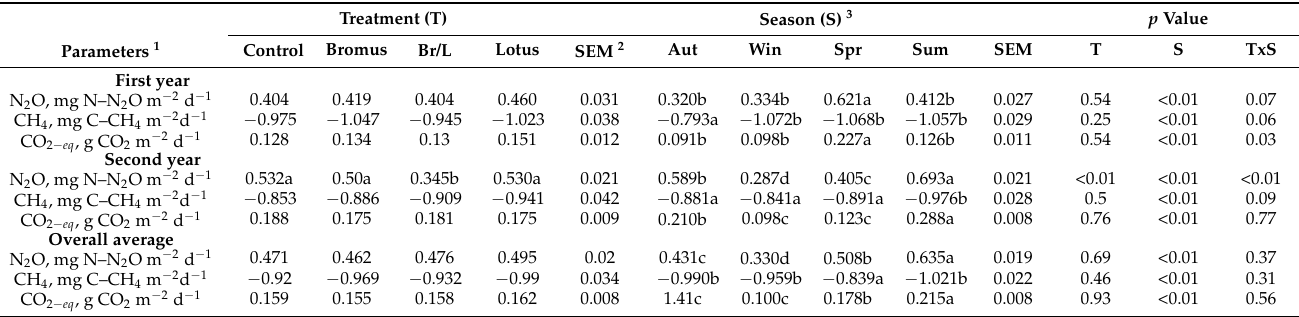
Table 3. Effect of treatments and season on average daily fluxes of N–N 2 O, C–CH 4 and CO 2 − eq during the first and second years, and overall